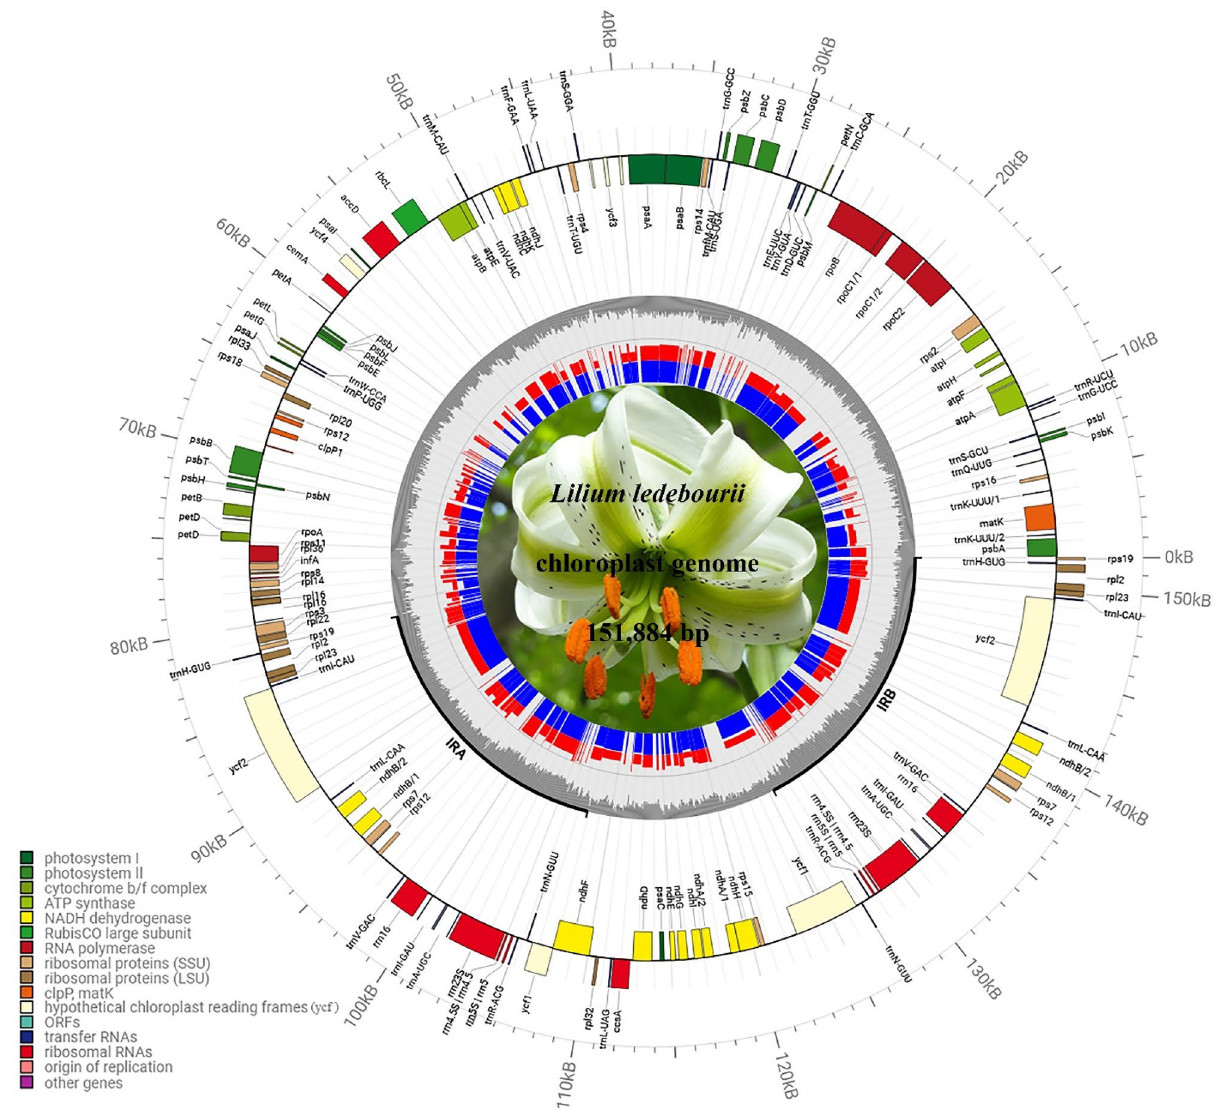
Figure 1. The chloroplast genome map of L. ledebourii . Transcriptional directions are represented on the circle’s inside (clockwise) and outside (counterclockwise). Genes are color-coded according to their functional